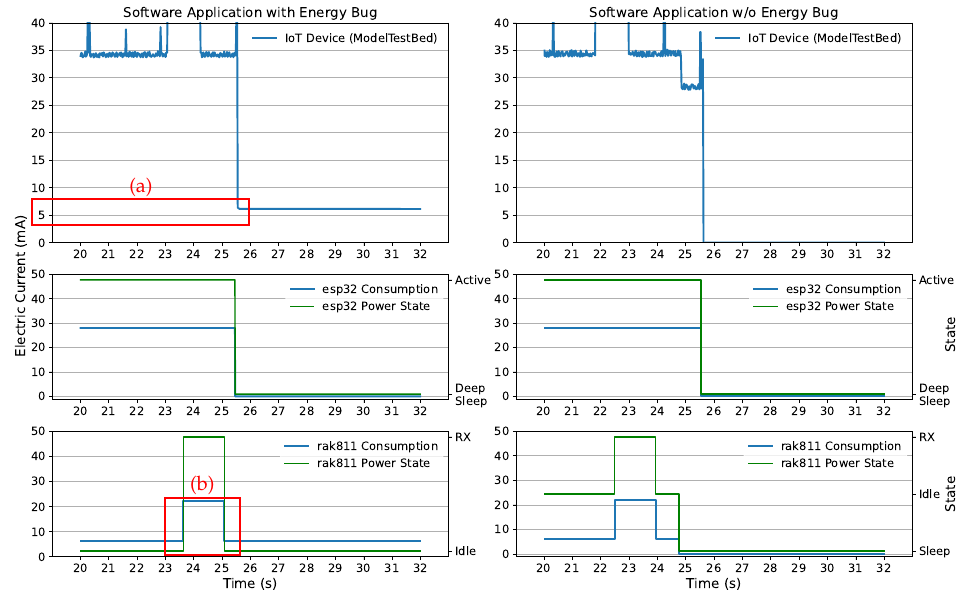
Figure 25. Analysis of a software application with (left) and w/o (right) a Type C energy bug. Techni- cal indicators for the presence of an energy bug are highlighted in red. The overall consumption ( a ) is higher than expected. The RAK811 module stays in a higher state ( b ) while the ESP32 is set into the deep sleep mode, which can be traced back to a design flaw in the software application.